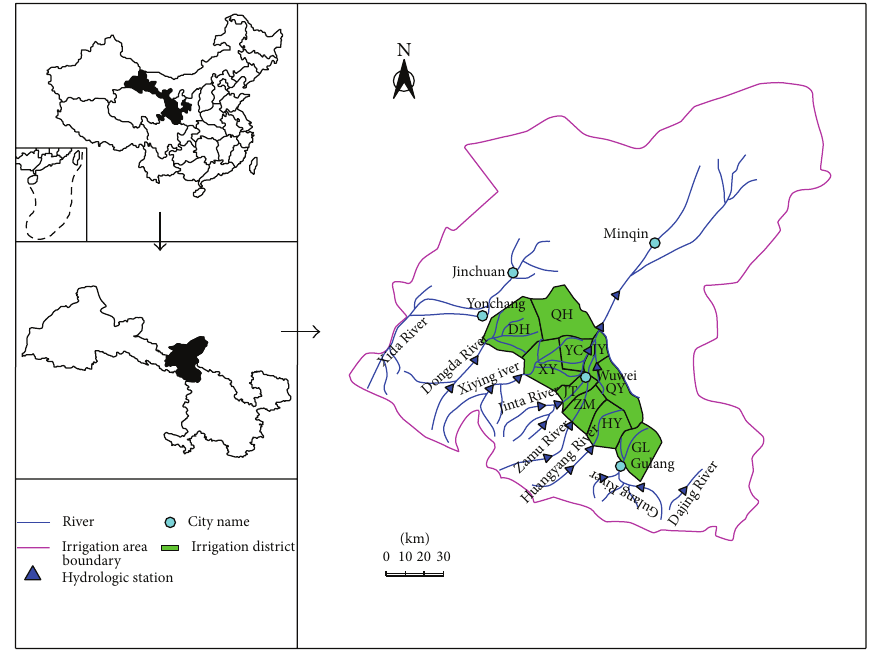
Figure 2: The study area.